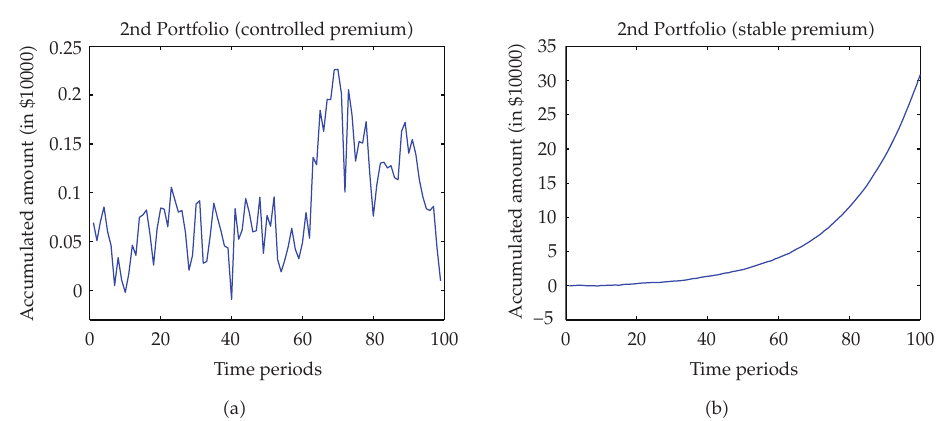
Figure 6: The accumulated profit/loss for (cid:5) stochastic (cid:7) controlled premium and stable premium, respectively, for the 2nd class of a heterogeneous Portfolio for the respective incidents, during 100 unit- time period (cid:5) 300000 simulations (cid:7) .